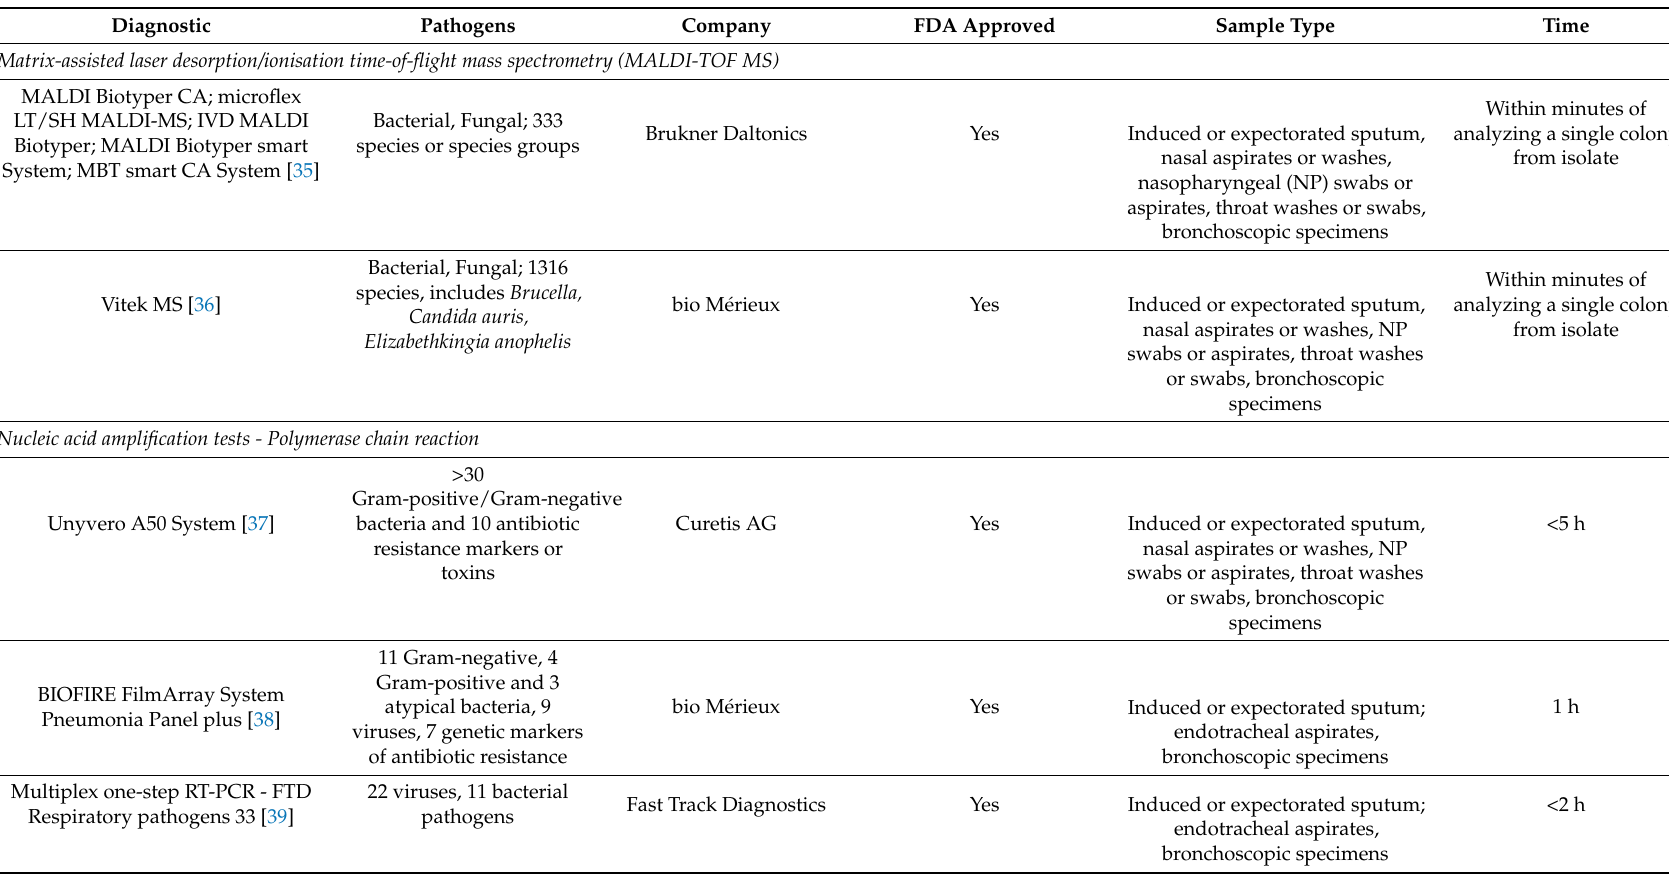
Table 2. Select diagnostics for bacterial lower respiratory tract infections